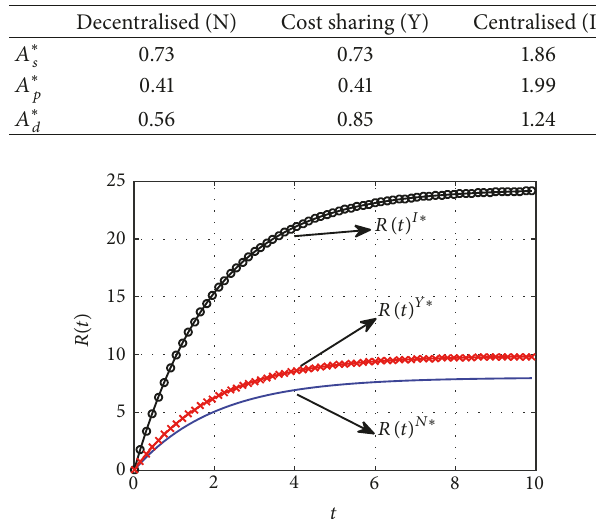
Figure 5: Dynamic change in manufacturing resources sharing level.